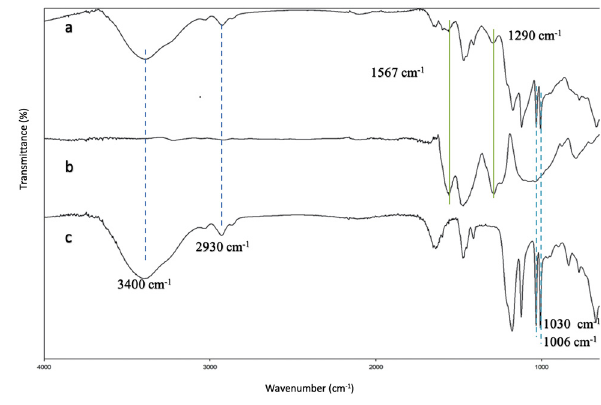
Figure 2: Plot of water uptake percentage of CPECs as a function of PANI loading percentage. Figure 3: FT - IR spectra of ( a ) composite PEC, ( b ) PANI, and ( c )